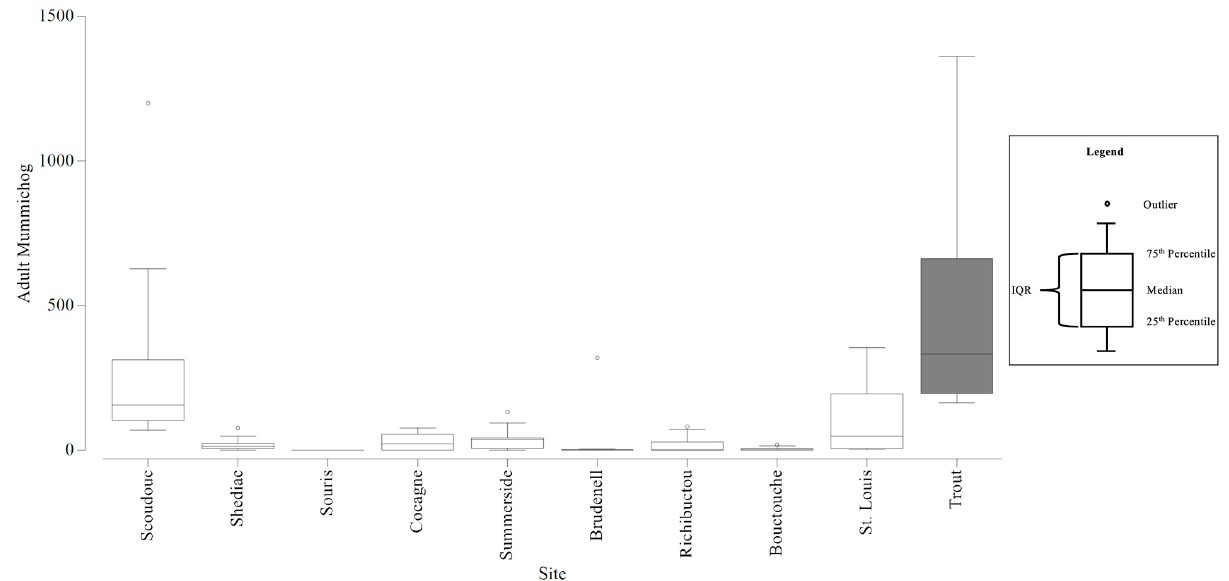
Figure 5. Boxplots generated using the adult Mummichog counts collected from the Community Aquatic Monitoring Program (CAMP) stations at each estuary. The box shaded dark grey identifies the adult Mummichog abundances that are significantly different from the abundances at the other estuaries, and the difference is large enough to be detected, with confidence, in consideration of the precision of the CAMP sampling design. Table 7. Minimum, maximum, and mean counts of the four influential species for each estuary.